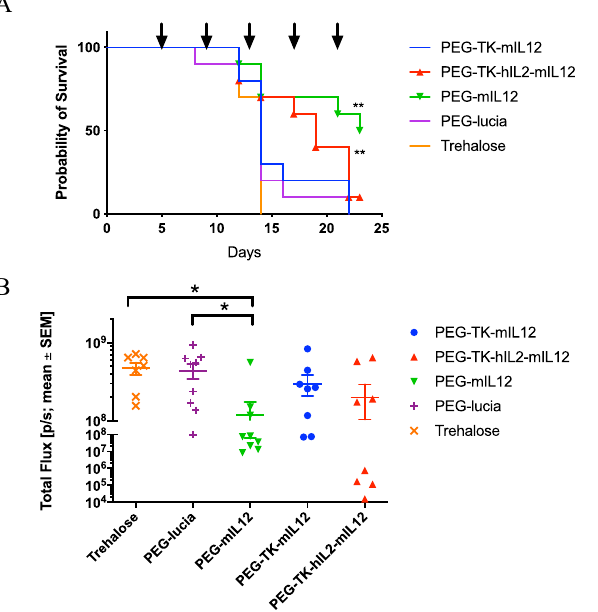
Figure 4. Activity of l-PEI/DNA nanoparticles in an LL/2 syngeneic, orthotopic model of primary lung cancer in C57BL/6 mice represented by a Kaplan Meier survival plot. Mice were inoculated orthotopically with LL/2 Red-FLuc murine lung cancer cell line and treated with nanoparticles at 4 d intervals, beginning at Day 5 (post tumor cell inoculation), as indicated by the arrows above the chart. The study was terminated on Day 23. Both PEG-TK-hIL2-mIL12 and PEG-mIL12 nanoparticles (red triangle and green upturned triangle, respectively) significantly ( p ≤ 0.001, Log-rank test) extended survival in this model compared to the vehicle control (9.5% trehalose control, solid line, open circle) and PEG-lucia (nanoparticle control, solid line, filled diamond ( A ). Anti-tumour activity of PEG-3 nanoparticles was assessed through comparison of the mean in vivo luminescence signal ± SEM (Total Flux (p/s)) in the lungs of mice at Day 13 after implantation of LL/2 Red- FLuc cells orthotopically into the lungs of C57BL/6 mice. There was a significant reduction in signal ( p ≤ 0.05, Dunnett’s multiple comparisons test) in the PEG-mIL12 group compared to the Trehalose vehicle control group indicating significant inhibition of tumor growth ( B